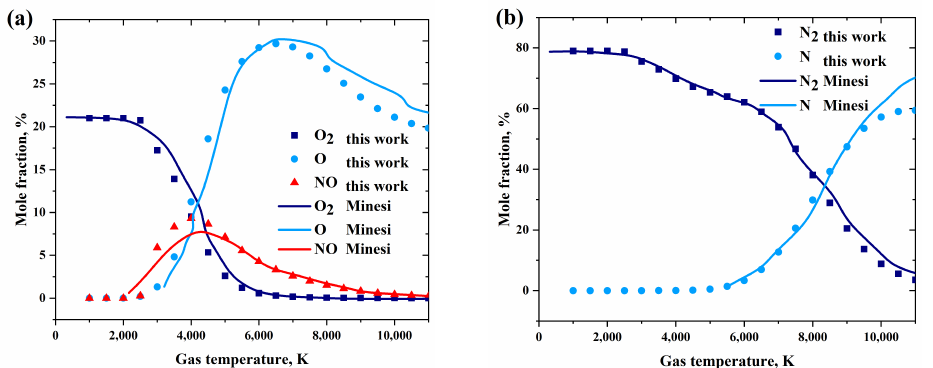
Figure 5. Equilibrium composition of the synthetic air as a function of the temperature in a constant volume process. ( a ) Comparison of O 2 , O, NO mole fractions, ( b ) Comparison of N 2 and N mole